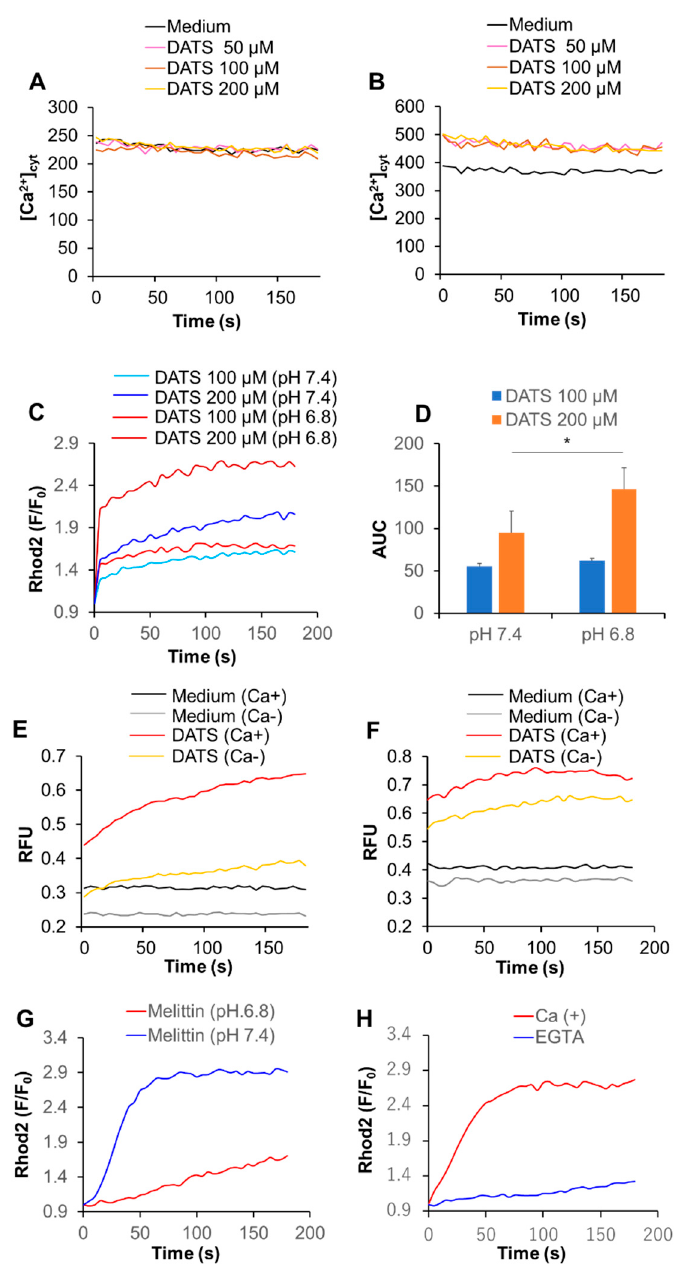
Figure 5. Acidification has a reciprocal e ff ect on Ca 2 + mit overload caused by DATS and melittin. ( A , B ) A375 cells were suspended in HBSS (pH 7.4) ( A ) and 6.8 ( B ), treated with the indicated concentrations of DATS, and measured for fluorescence with excitation and emission at 485 and 538 nm, respectively in a microplate fluorescence reader. ( C , D ) Dihydrorhod2-AM-loaded A375 cells were suspended in HBSS (pH 7.4 or 6.8), treated with DATS (100 and 200 µ M) and measured for fluorescence with excitation and emission at 542 and 592 nm, respectively, in a microplate fluorescence reader. Data are shown as F / F 0 , where F and F 0 represent the fluorescence of the sample and control, respectively ( n = 3–5). The data shown in ( D ) represent mean ± SD of the area under the curve (AUC) for 3 min ( n = 3). ( E , F ) The cells were suspended in HBSS, pH 7.4 ( E ) or 6.8 ( F ) containing 1 mM CaCl 2 (Ca + ) or 1 mM EGTA (Ca − ), treated with DATS (200 µ M), and measured for the fluorescence as described above. Data are shown as relative fluorescence unit (RFU). ( G , H ) The cells were suspended in HBSS (pH 7.4 or 6.8) ( G ) or HBSS (pH 7.4) containing 1 mM CaCl 2 (Ca + ) or 1 mM EGTA (Ca − ) ( H ), treated with melittin (2.5 µ g / mL) and measured for the fluorescence. * p < 0.05.